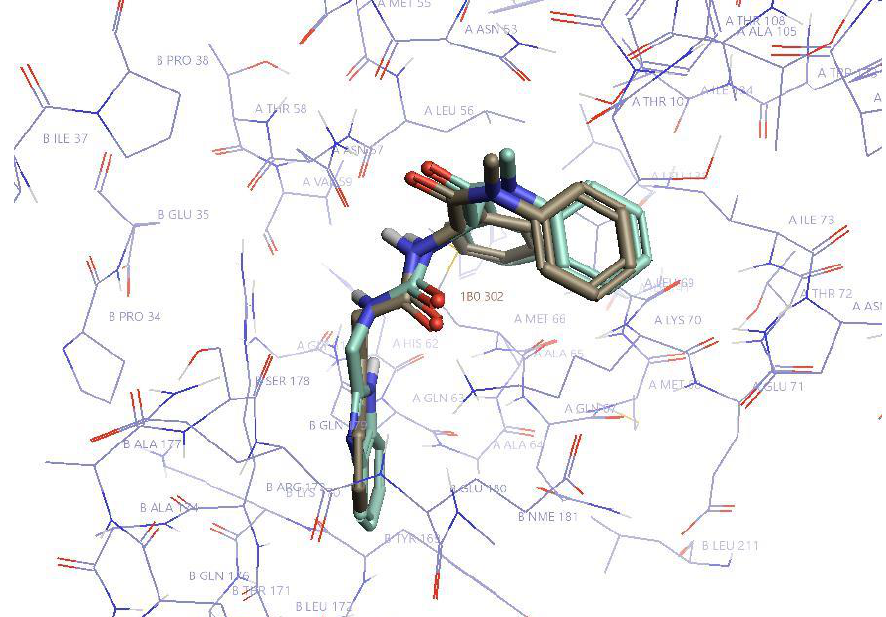
Figure 6. The structures of PF74 and D10. PF74 is in khaki and D10 in pale green. Hydrogen atoms are omitted for simplification. The most important residues of CA-NTD ( A ) and CA-CTD ( B ) for the inhibitor binding are labeled. Created in Flare (Cresset Inc., New Cambridge House, Bassingbourne Road, Littlington, Cambridgeshire SG8 0SS, UK).